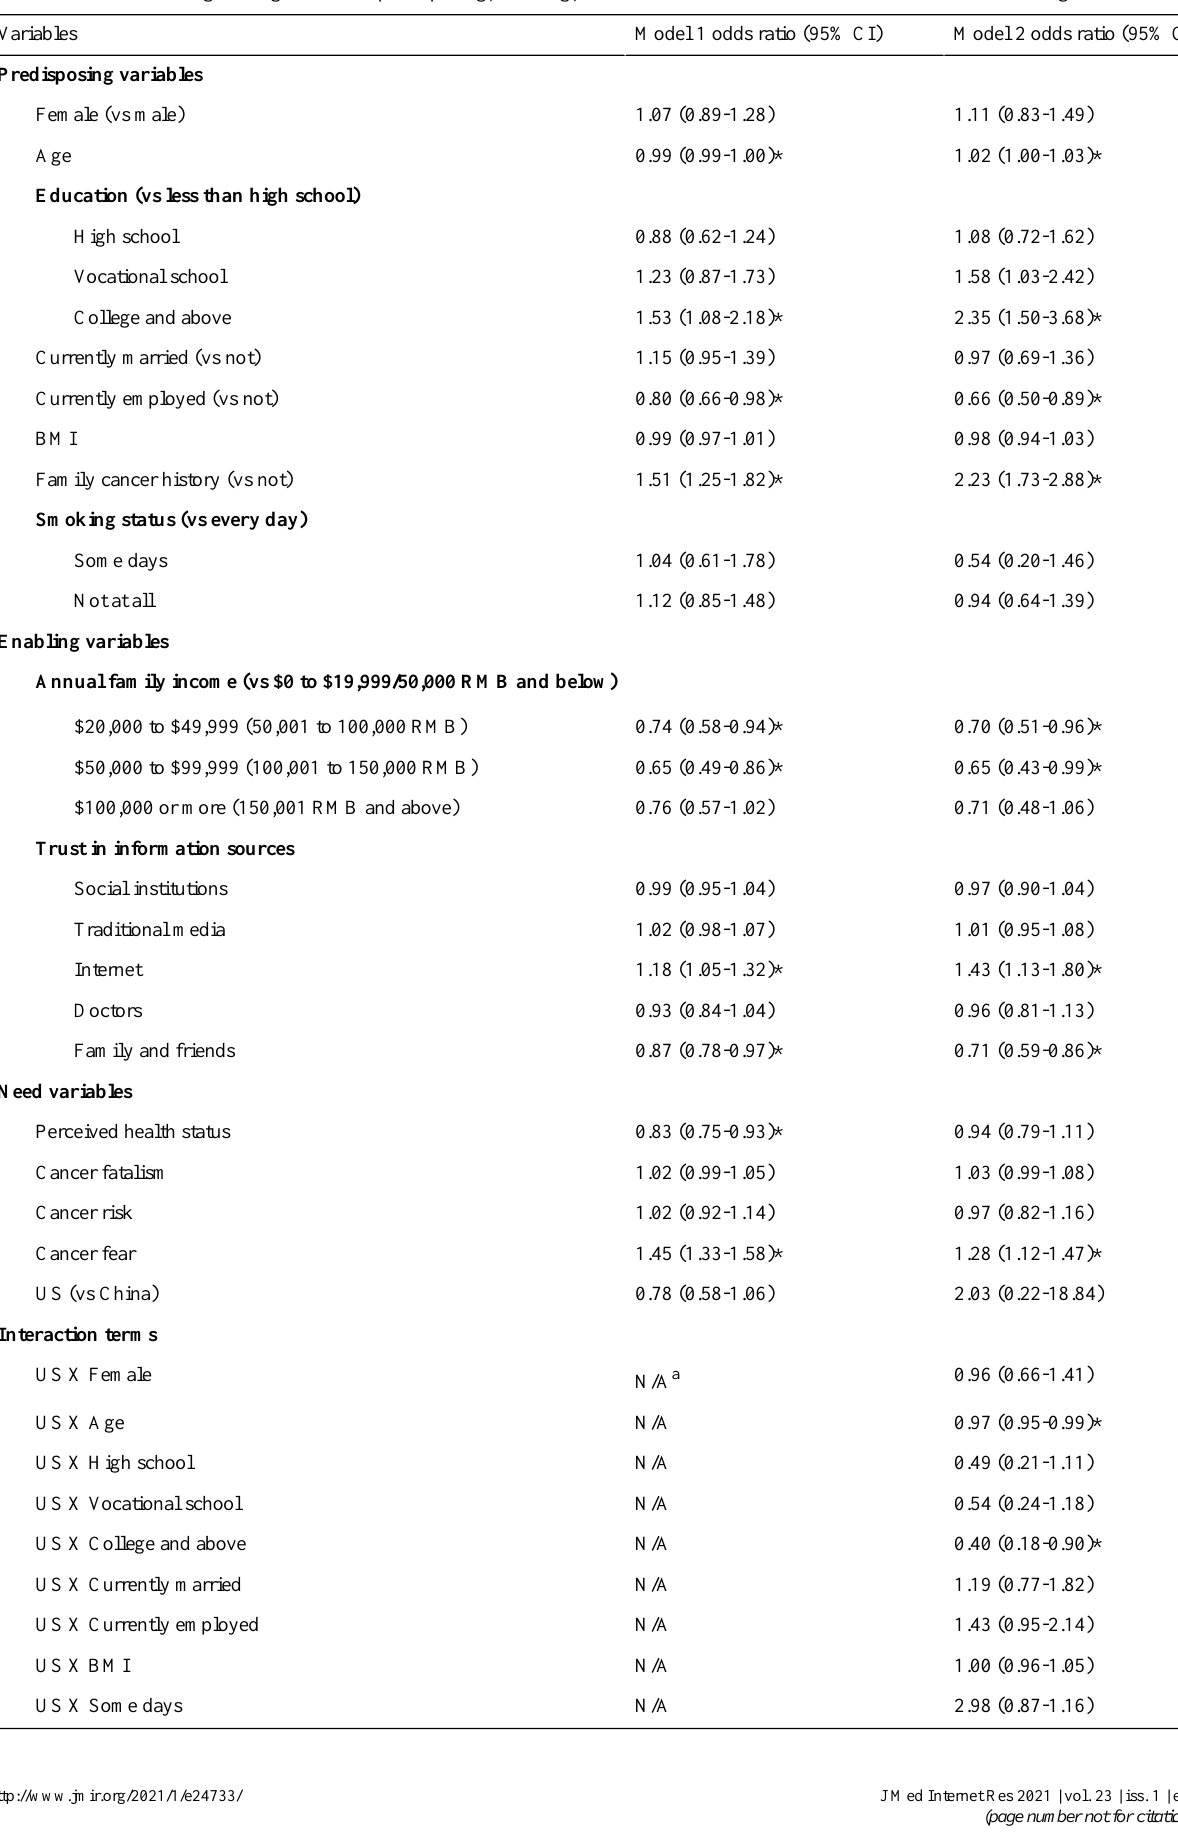
Table 1. Odds ratio of logistic regressions of predisposing, enabling, and need variables of internet cancer information